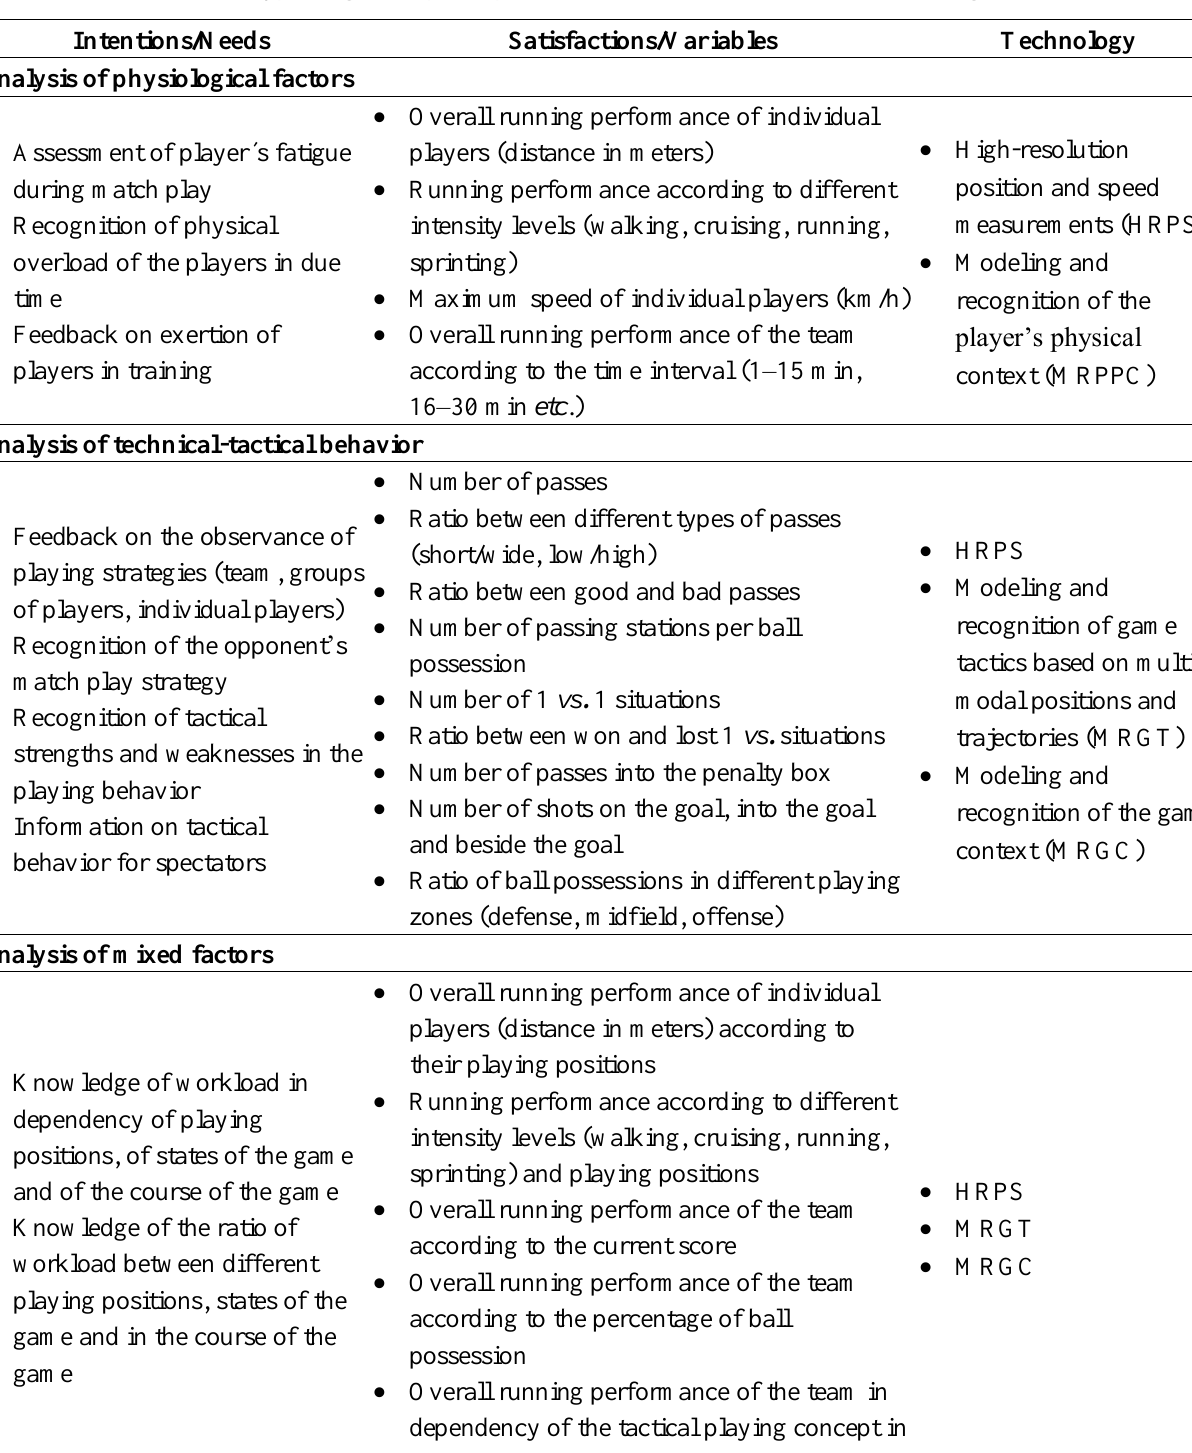
Table 1. Typical game sport specific demands and solutions according to